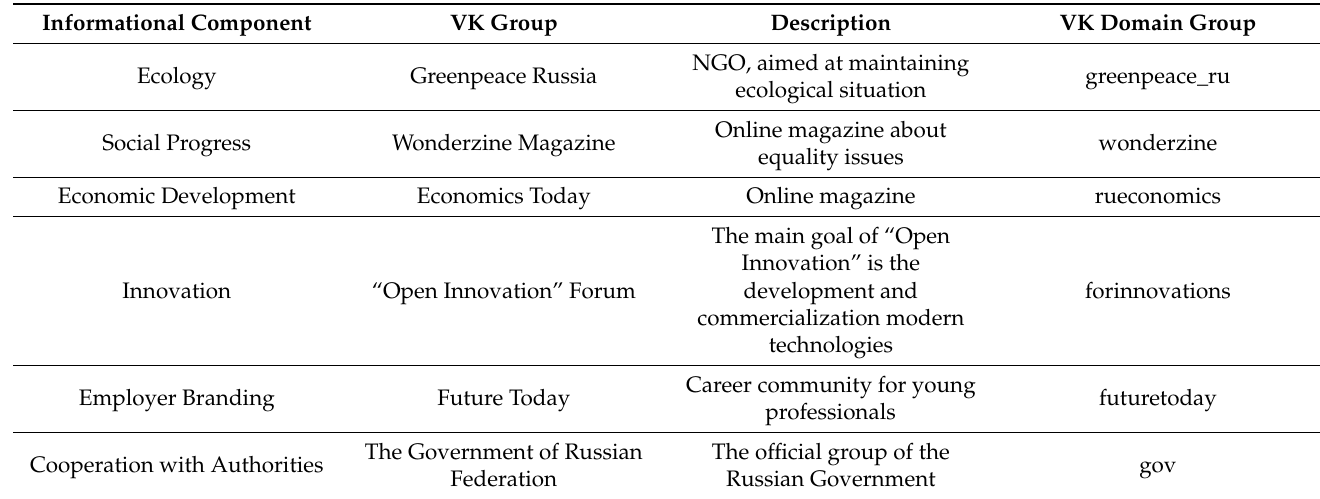
Figure 4. The architecture of a tool that analyzes the digital image of an enterprise. To analyze the presence of digital components, it is necessary to collect their most frequently encountered tokens. The environments of tokens of digital components must be determined—in this study, thematic groups on VK were used as these environments. Collected and tokenized texts from these groups can be seen in Tables 1 and 2. Table 1. Description of informational components.